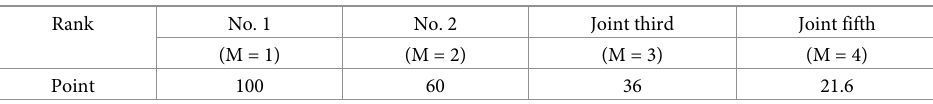
Table 1. Scoring rule of the 2020 NTCS.